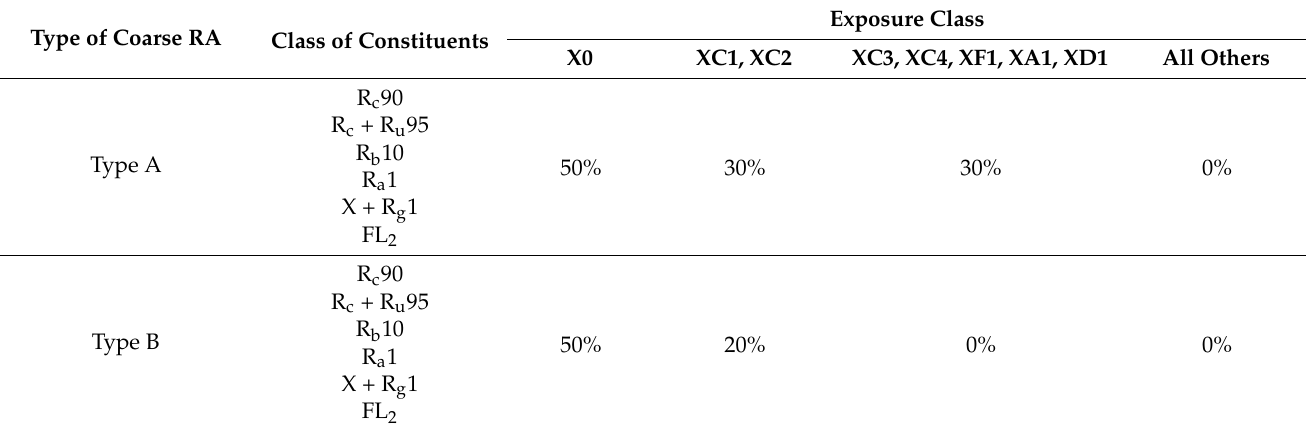
Table 4. Types of CRA and maximum recommended incorporation ratios of EN206